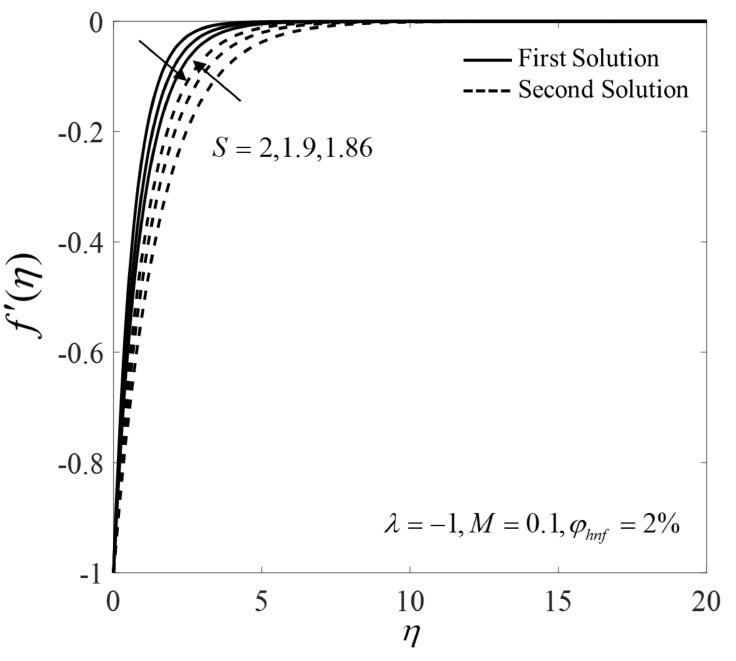
Figure 10. Velocity profiles f (cid:48) ( η ) or different values of suction strength S .